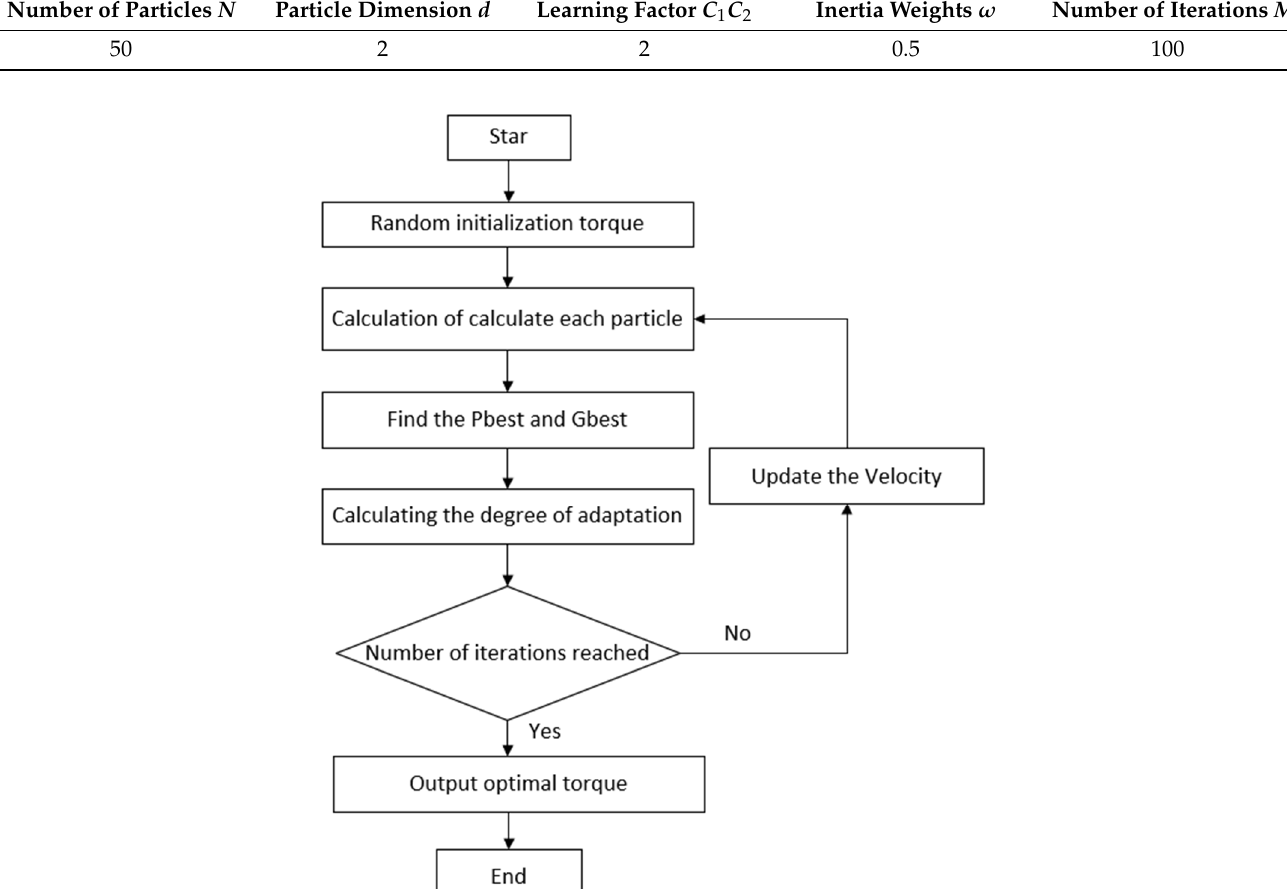
Table 1. PSO algorithm parameters.